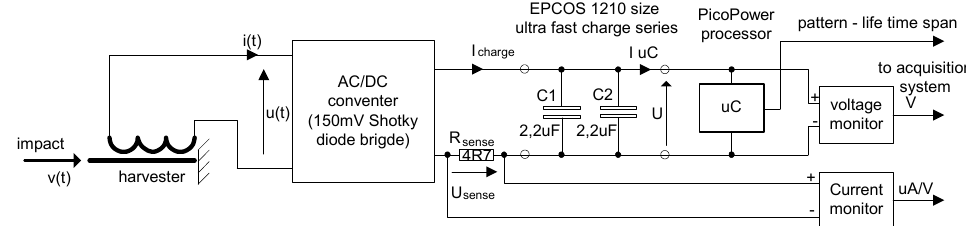
Figure 9. Supply current and voltage measurement scheme for detecting the lifetime of a powered microcontroller.